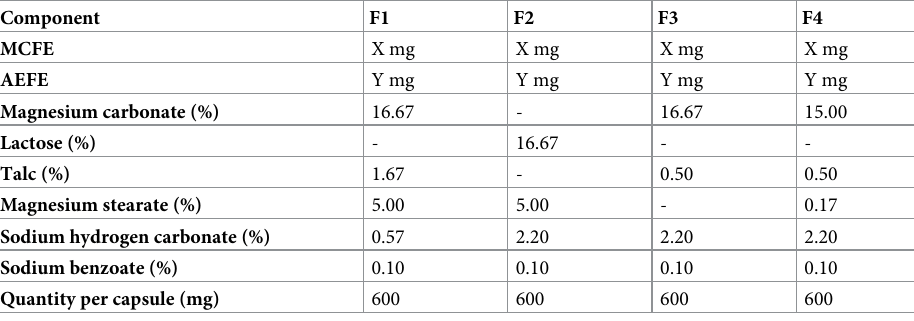
Table 2. Proposed formulation compositions for herbal capsule. Component F1